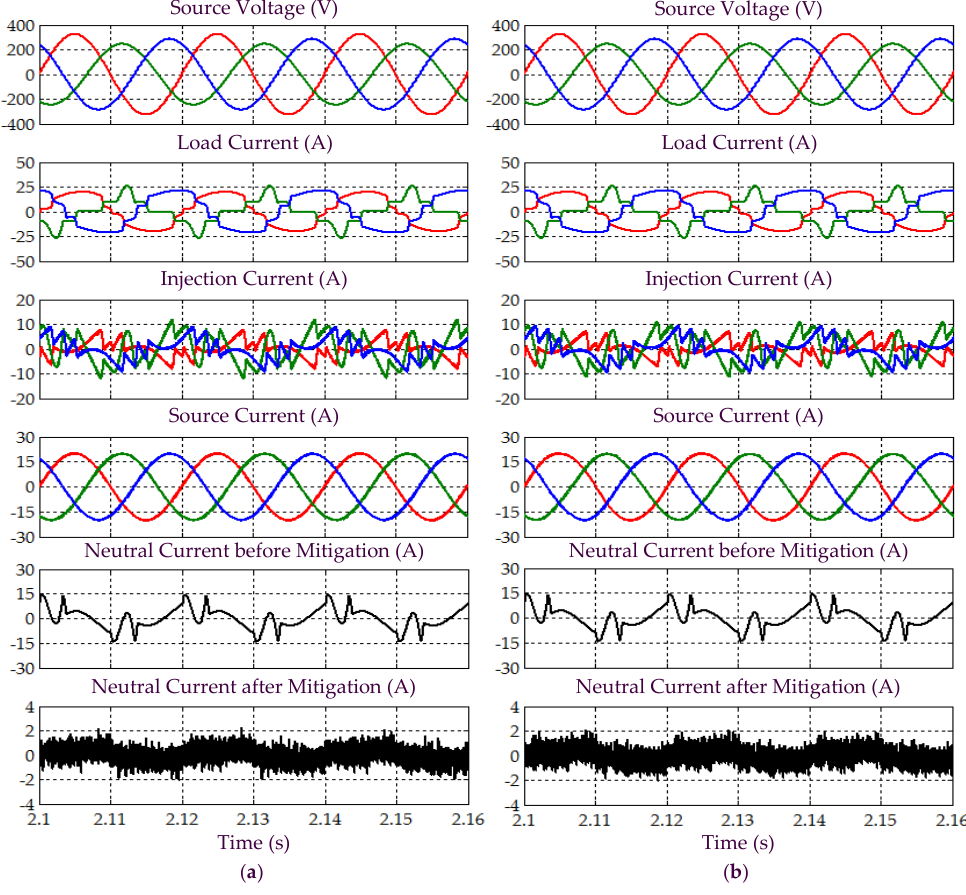
Figure 18. Simulation results obtained under Scenario C for Load 2, which include three-phase source voltage 𝑣 𝑆𝑎𝑏𝑐 , load current 𝑖 𝐿𝑎𝑏𝑐 , injection current 𝑖 𝑖𝑛𝑗𝑎𝑏𝑐 , source current 𝑖 𝑆𝑎𝑏𝑐 , and neutral current before and after mitigation, demonstrated by SAPF while applying the ( a ) proposed STF- dq 0 and ( b ) standard dq 0 techniques.